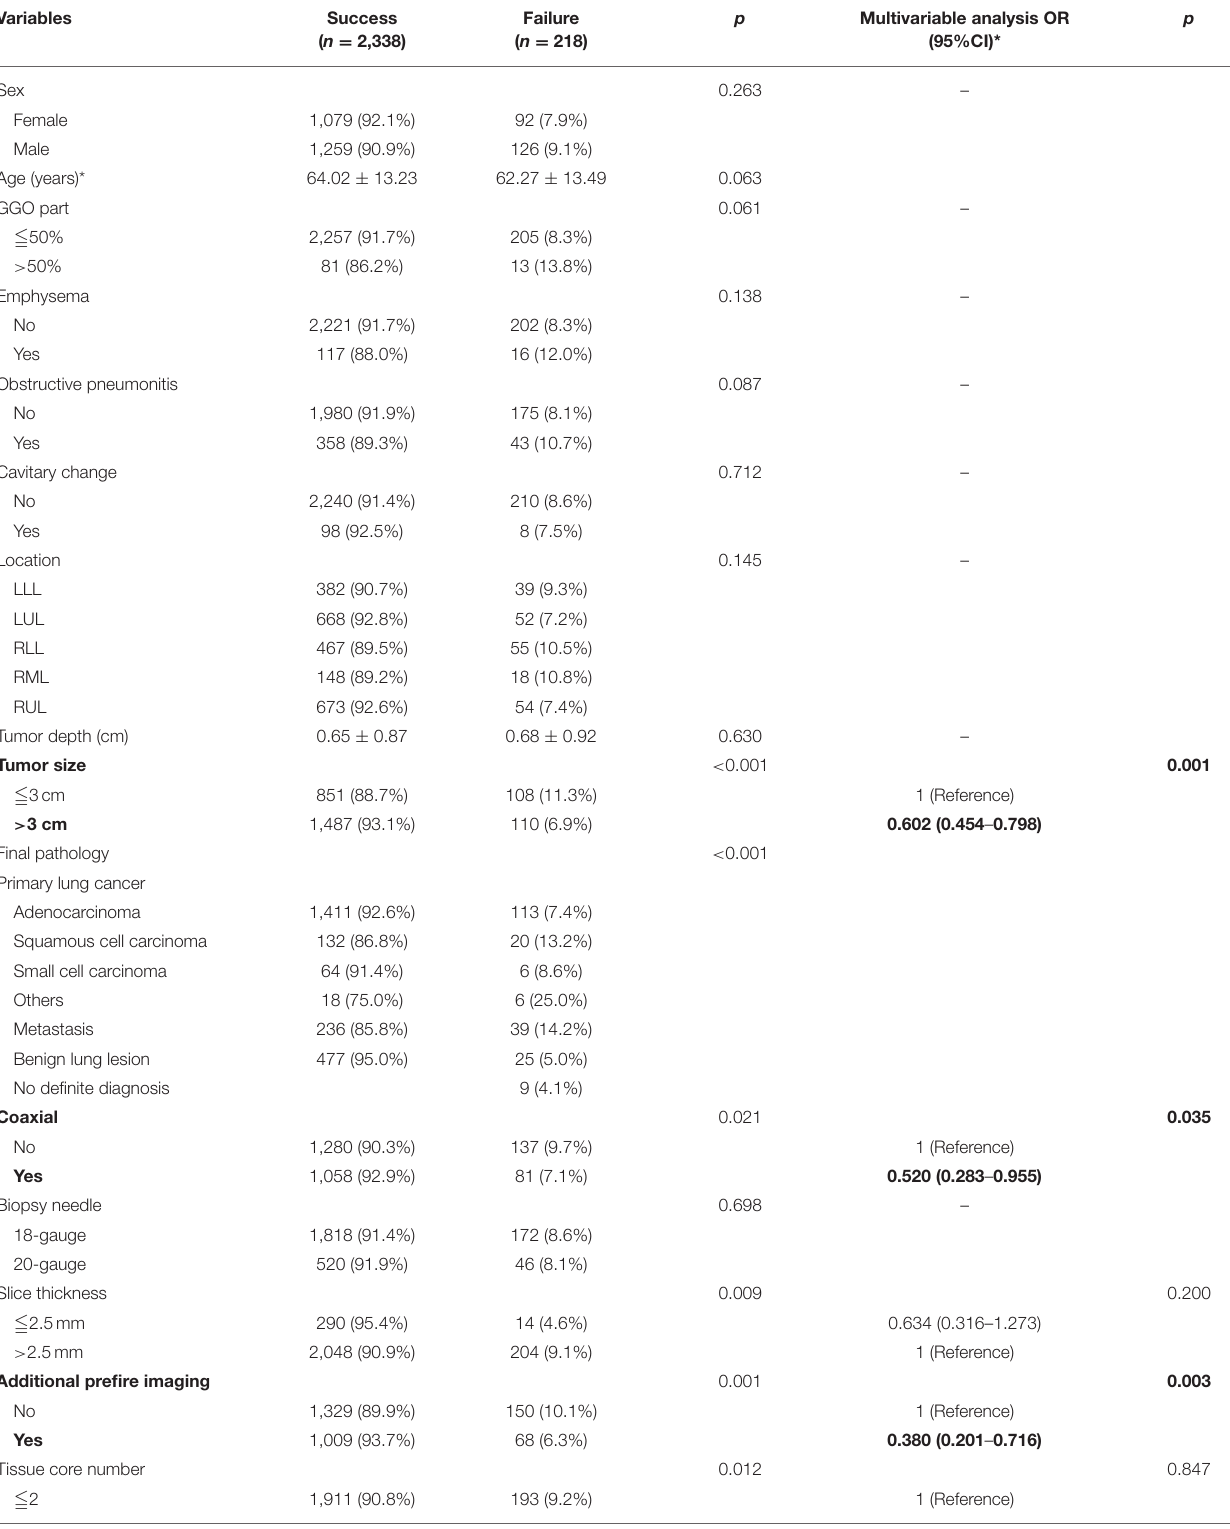
TABLE 1 | Baseline demographic, clinical characteristics, radiologic features, and pathology results of predictors for diagnostic failure of CT-guided TTNB.